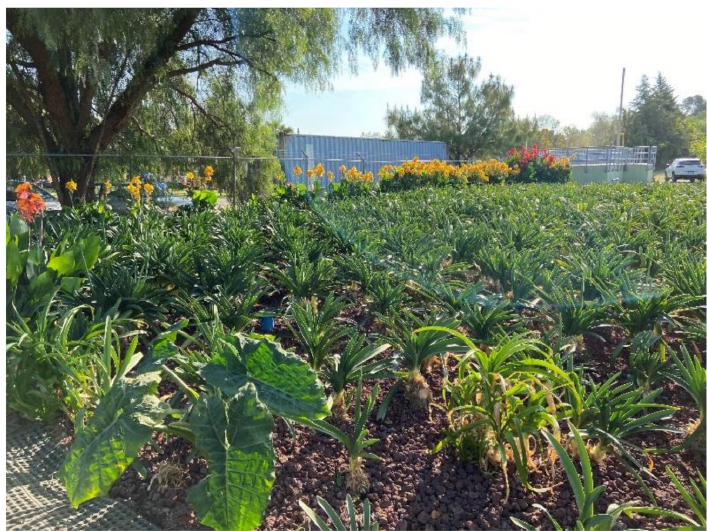
Figure 1. Horizontal flow constructed wetland (HFCW) planted with Agapanthus africanus .